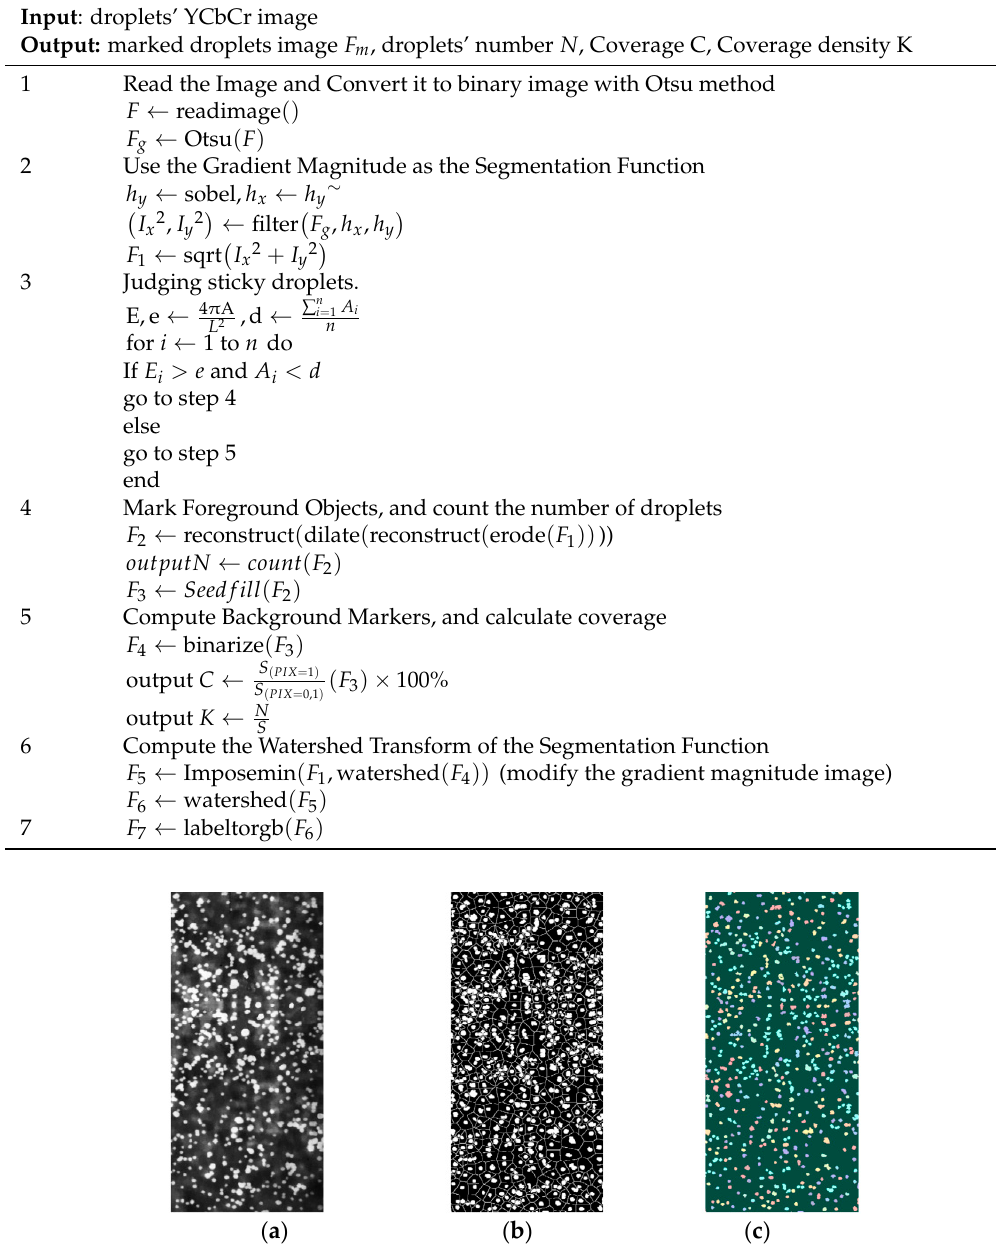
Table 1. Modified marker controllable watershed segmentation algorithm.